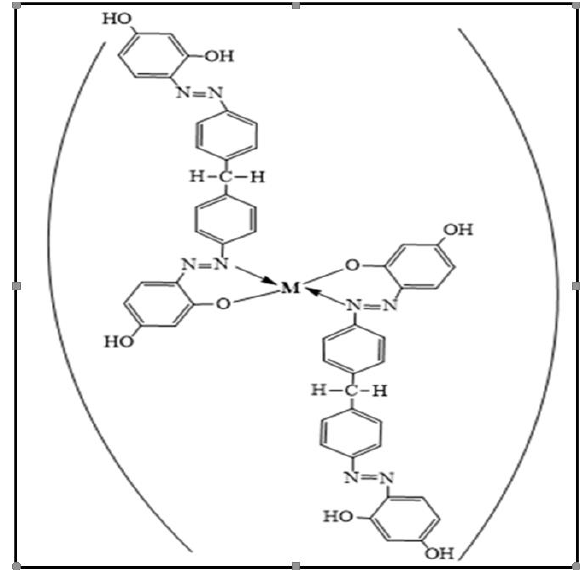
Fig. 2. Proposed ligand structures with its